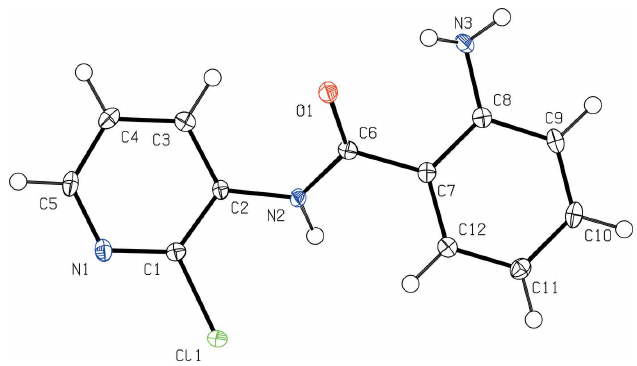
Figure 1 The molecular structure, with displacement ellipsoids drawn at the 50% probability